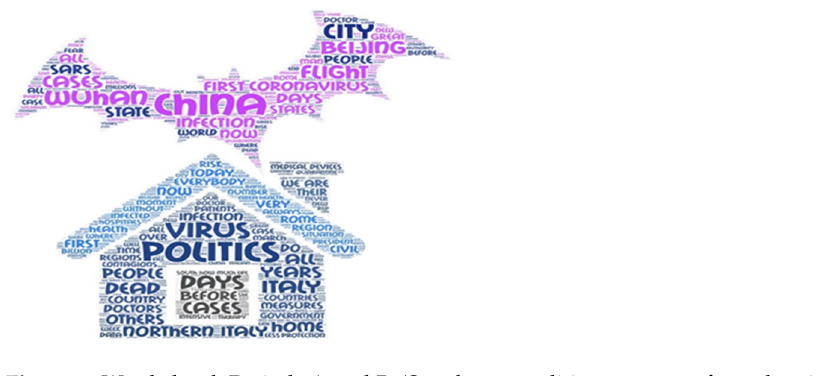
Figure 1. Word cloud, Periods A and B: ‘Stay home: politics saves you from the virus’.